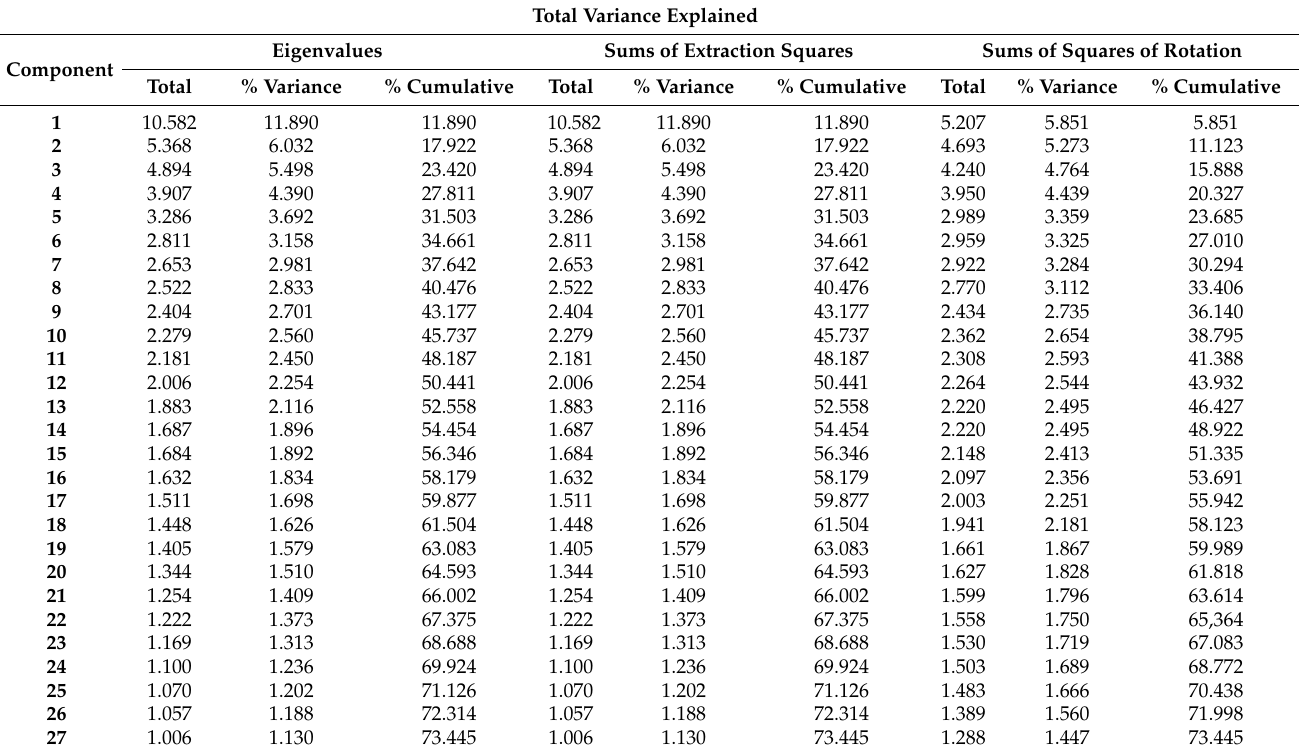
Table A1. Ranking of municipalities based on abandonment index for nine metropolitan cities in Sicily.